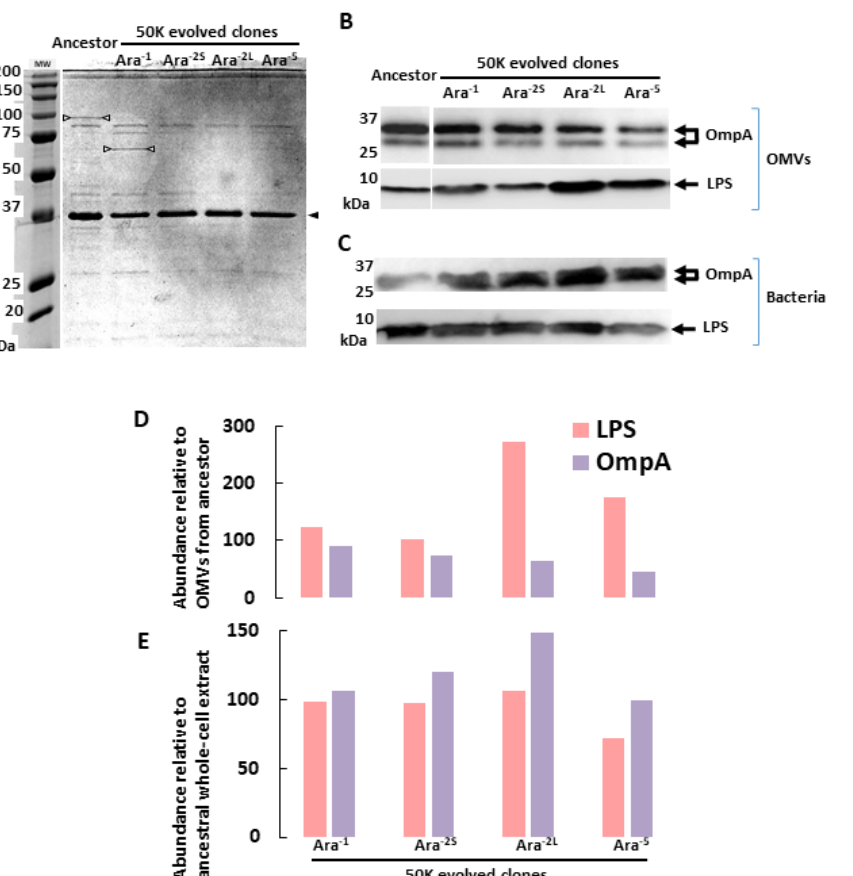
Figure 2. E. coli adaptation to the LTEE conditions leads to biochemical changes in OMV production. ( A ) Protein profiles of OMV preparations: equivalent amounts of OMVs (7.5 µ g of total lipids) were separated on a 12% SDS-PAGE and revealed by Coomassie blue staining. The black arrowhead points to the major OmpA band migrating at the expected apparent molecular weight of 35 kDa. The white arrowheads point to unknown proteins that vary in abundance depending on the analyzed OMV preparation. ( B ) Equivalent quantities from each OMV preparation (corresponding to 7.5 µ g of lipids) were separated on a 12% SDS-PAGE, transferred to nitrocellulose, and revealed by immunoblot using either polyclonal anti-OmpA or monoclonal anti- E. coli LPS antibodies. ( C ) Whole cell extracts of each bacterial clone (corresponding to 3 µ g of proteins) were separated on a 12% SDS-PAGE, and immunoblotted using either polyclonal anti-OmpA or monoclonal anti- E. coli LPS antibodies. ( D , E ) The OmpA and LPS signals from immunoblots illustrated in B and C were quantified using Imagelab and presented as percentages relative to the ancestral strain signals for OMV preparations in D or for whole cell extracts in E.